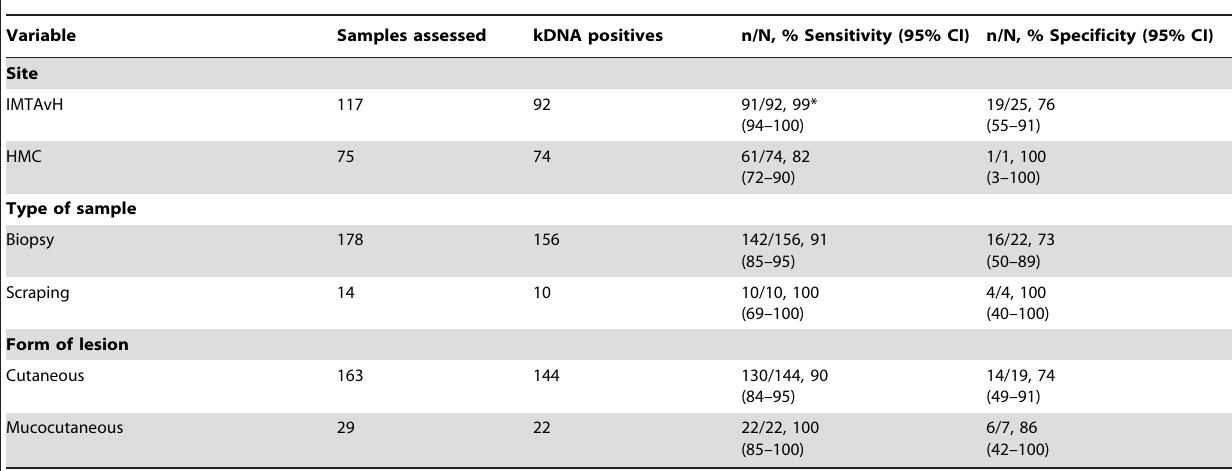
Table 5. Sensitivity and specificity of the real-time PCR assay compared to kDNA PCR stratified by site, type of sample and type of